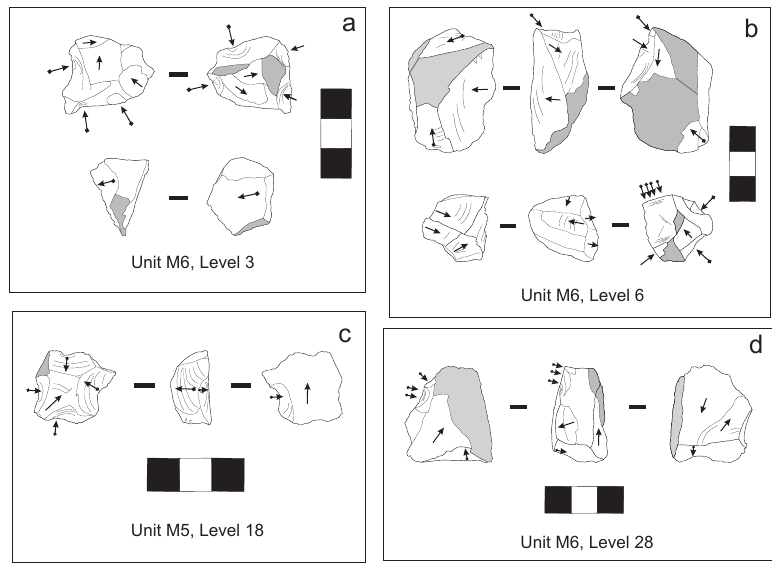
Figure 7 - Cores found at different stratigraphic positions, all showing the same general technological characteristics. a : Cores on quartz crystal, Level 3, later than 4200 cal BP; b : Cores on quartz crystal, Level 6, 4400 cal BP; c : Core on quartz crystal, Level 18, ca. 9500 cal BP; d : Core on flint, Level 28, ca. 10,000 cal BP.